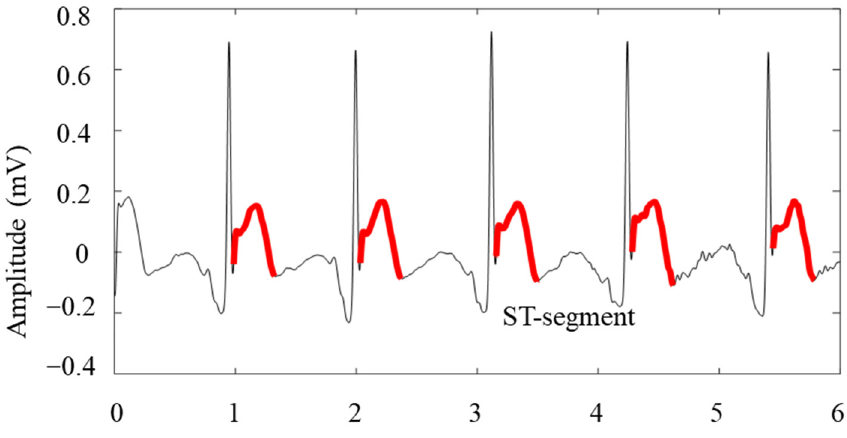
Figure 7. ST segment localization in patients with inferior myocardial infarction.